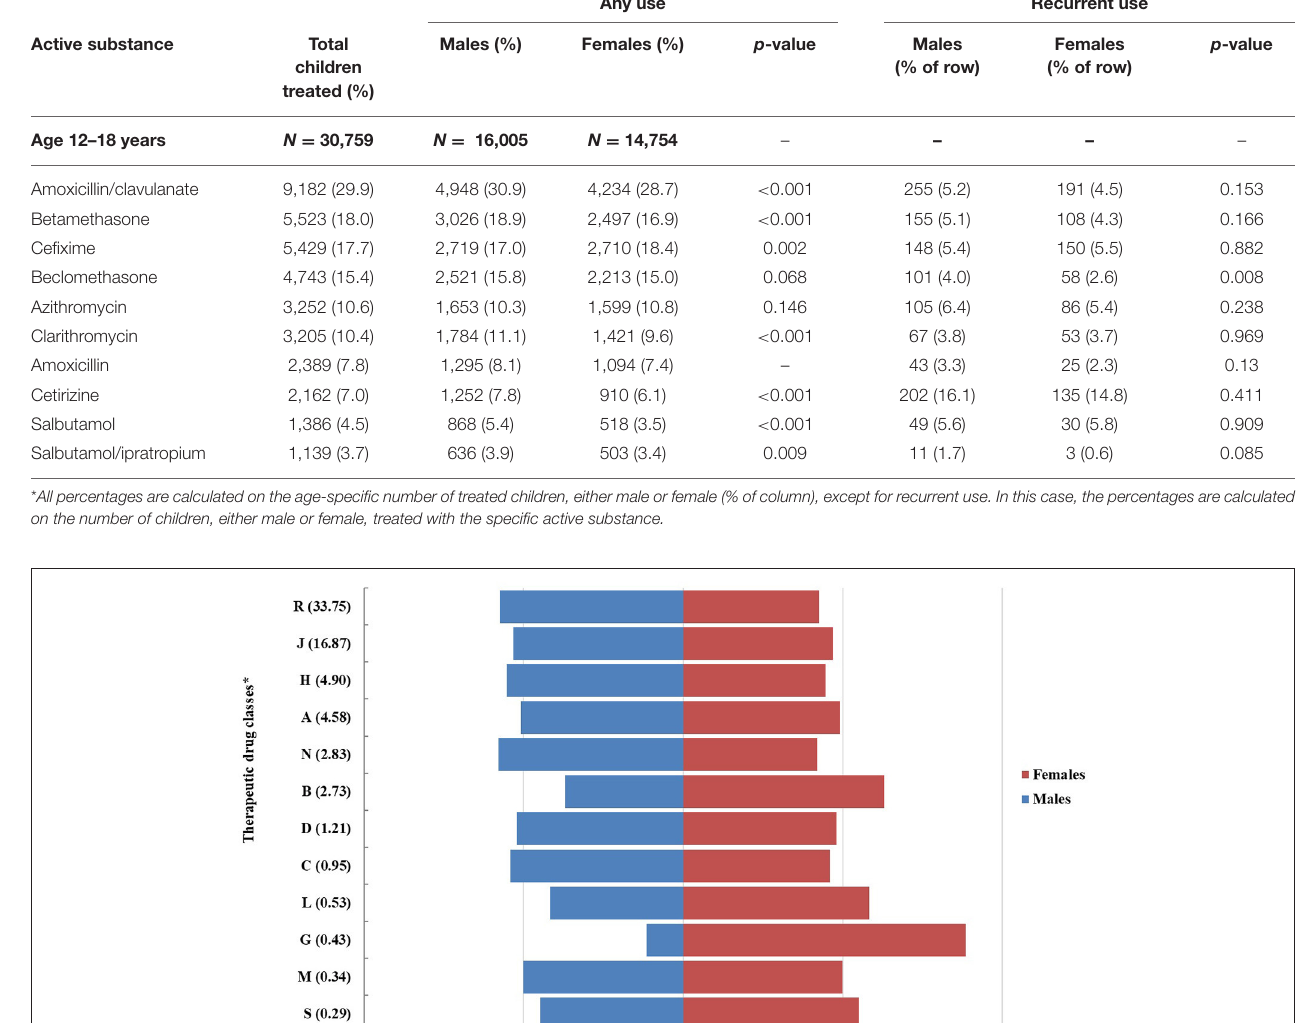
likely due to a decreased prescribing trend of antibiotics.